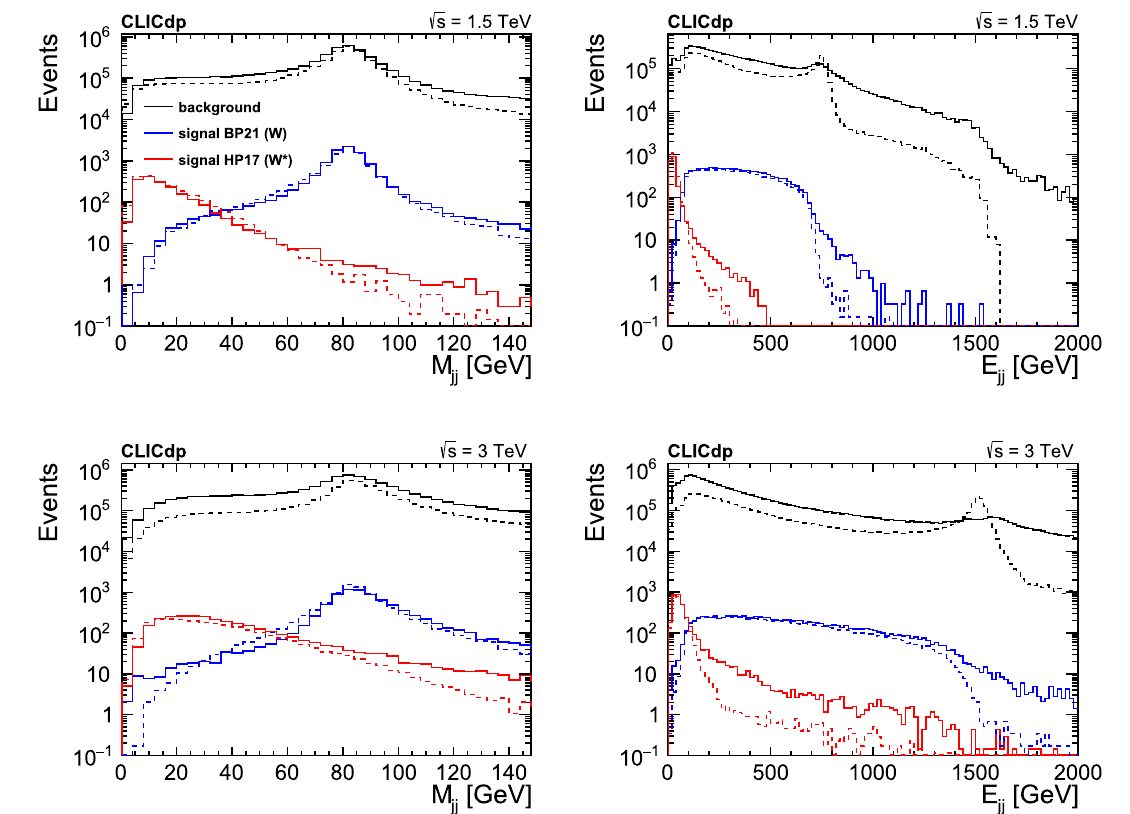
Fig. 3 Histograms of the masses (left) and the energies (right) of a dijet system at 1.5TeV (upper) and 3TeV (bottom). The red line denotes HP17, and the blue one BP21. The black histogram is the sum of all background channels. Histograms are normalized to the number of events expected in the real experiment. Solid line shows the full simulation histograms and the dashed line the corresponding fast simulation